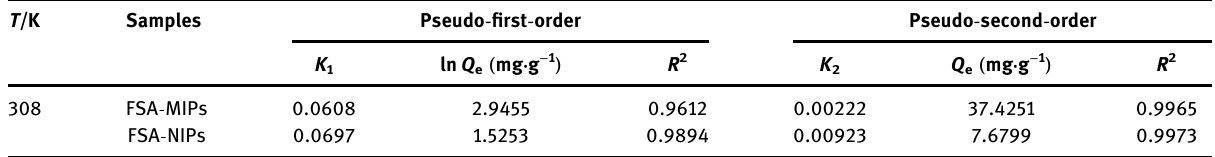
Table A2: Adsorption kinetic parameters for the adsorption of 4 - MMC onto FSA - MIPs and FSA - NIPs at di ff erent temperatures T /K